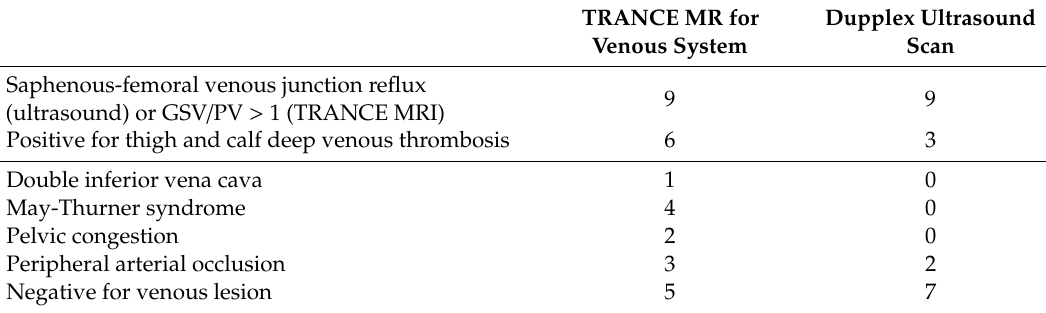
Table 2. Comparison between TRANCE MRI and Duplex ultrasound scan.